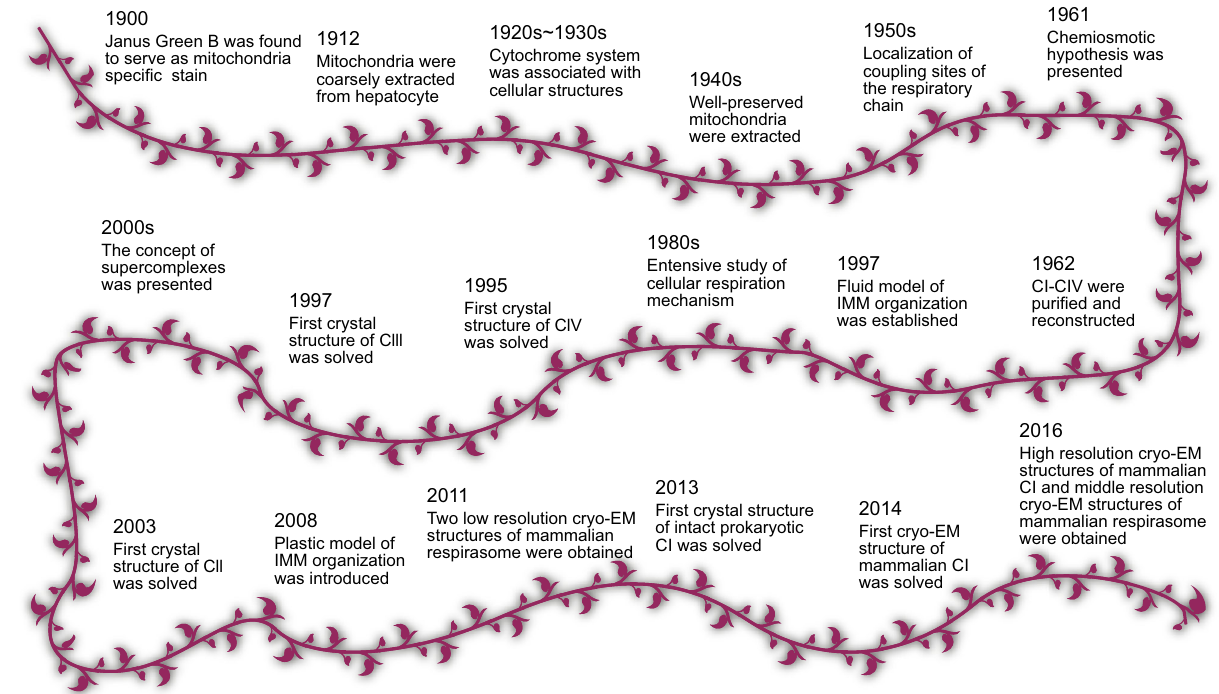
Figure 1. Brief research history of the respiratory